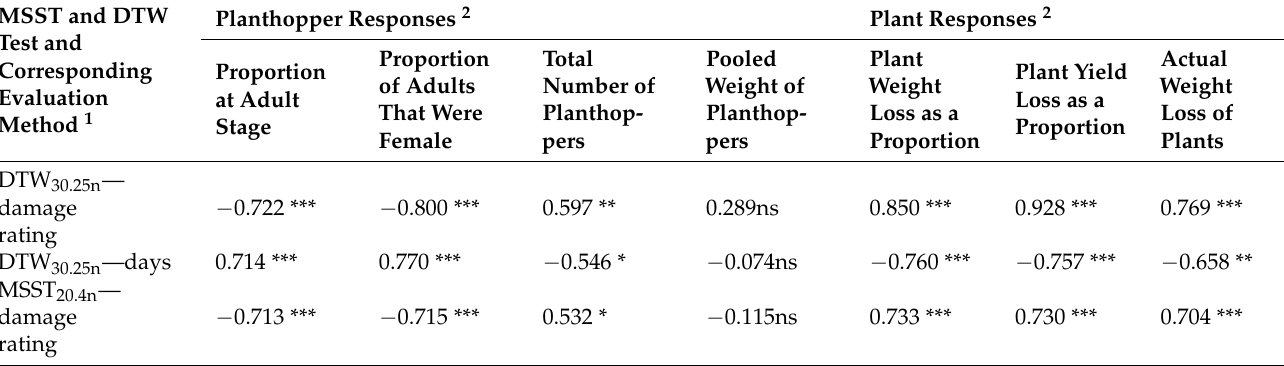
Table 3. Spearman’s coefficients ( r s 16 ) for correlations between damage ratings and time for plants to wilt in the DTW 30.25n test and herbivore- and plant-response parameters estimated from the same test. Correlations with MSST 20.4n damage ratings are also shown.